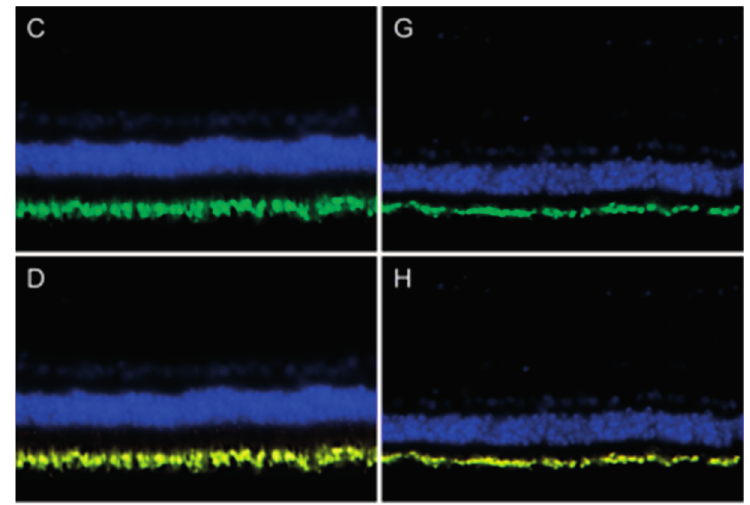
Figure 1. Expression pattern of peripherin 2 (red) and rhodopsin (green) in representative retinas of healthy ( left ) and equine recurrent uveitis (ERU) cases ( right ). Differential interference contrast image of healthy ( A ) and diseased ( E ) equine retina. Peripherin 2 (red) was equally distributed in the photoreceptor outer segments of healthy ( B ) and diseased ( F ) equine retina. Cell nuclei were stained with 4',6-diamidino-2-phenylindol (DAPI) (blue); Rhodopsin (green) was also equally distributed in photoreceptor outer segments of healthy ( C ) and uveitic ( G ) retinas. The overlap of peripherin 2 and rhodopsin in healthy ( D ) and uveitic ( H ) retina show overlapping expression pattern of both proteins